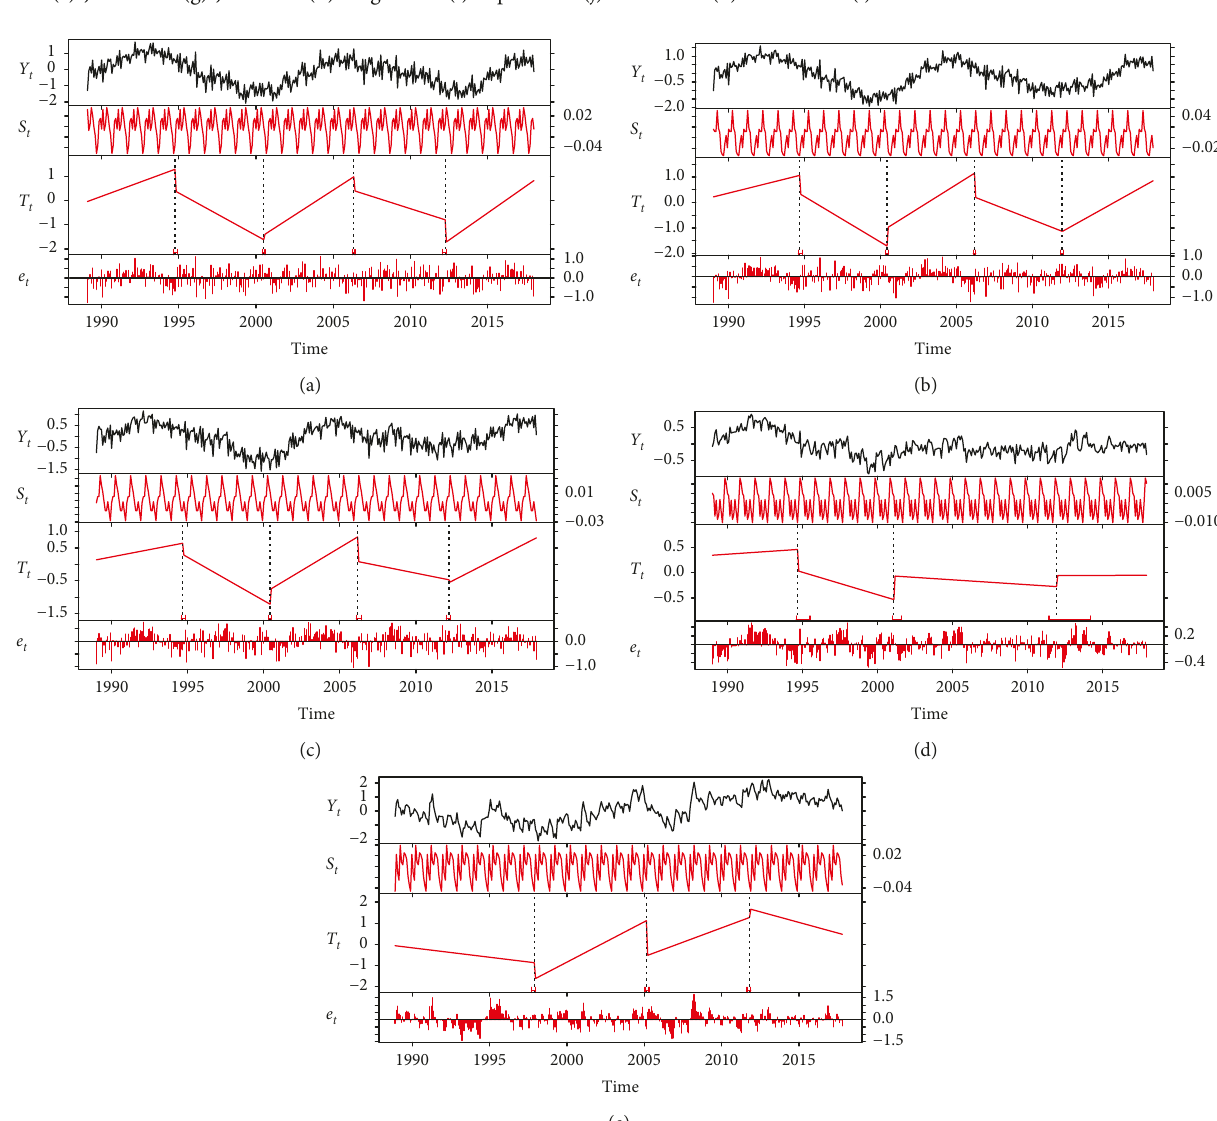
Figure 5: Trends of monthly scPDSI for the subregions. (a) Equatorial. (b) Arid. (c) Warm. (d) Snow. (e)